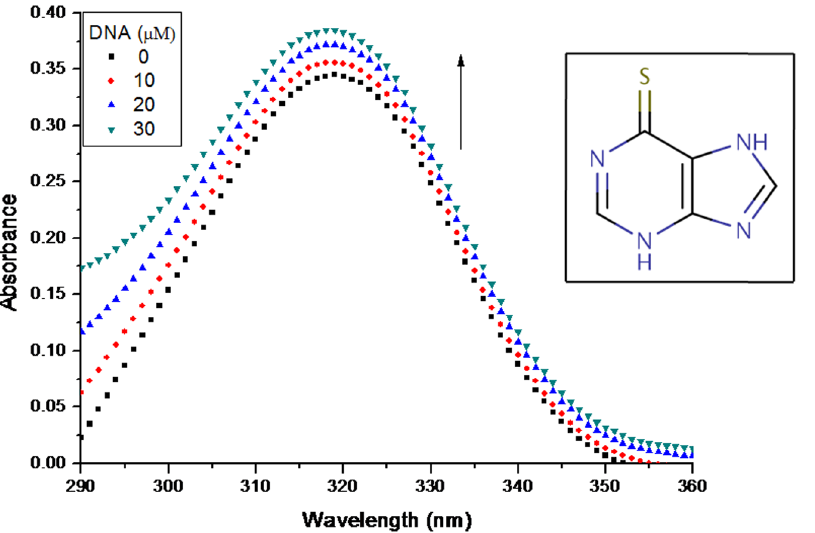
Figure 1. Interaction of 6MP with CT-DNA. UV-visible absorption spectra of 6MP (25 m M) in presence of increasing concentrations of CT-DNA in Tris-HCl buffer (pH 7.2). Hyperchromism was observed with increasing concentration of CT-DNA confirming the interaction of 6MP and DNA. Structure of 6 Mercaptopurine is shown in the inset.